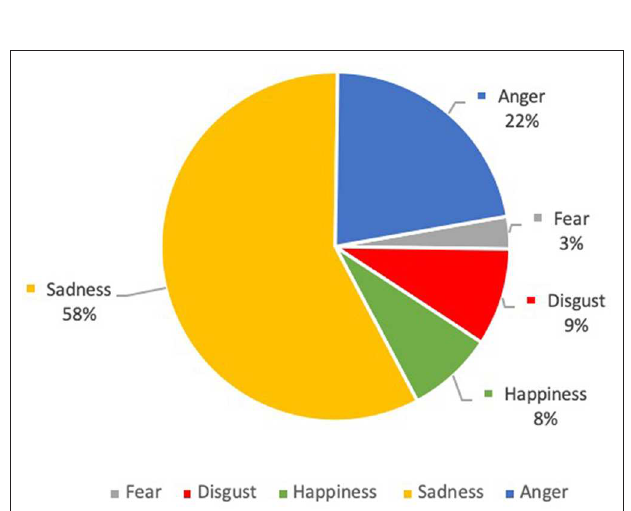
FIGURE 7 | Developmental trajectory for each emotional category.